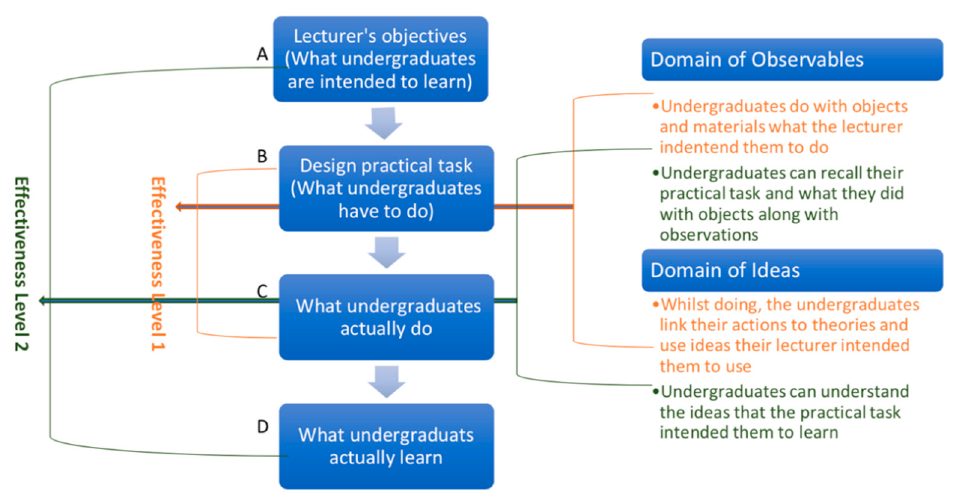
Figure 1. Theoretical model for the e ff ectiveness of practical work. Adaptation from Millar et al. (1999) and Tiberghien